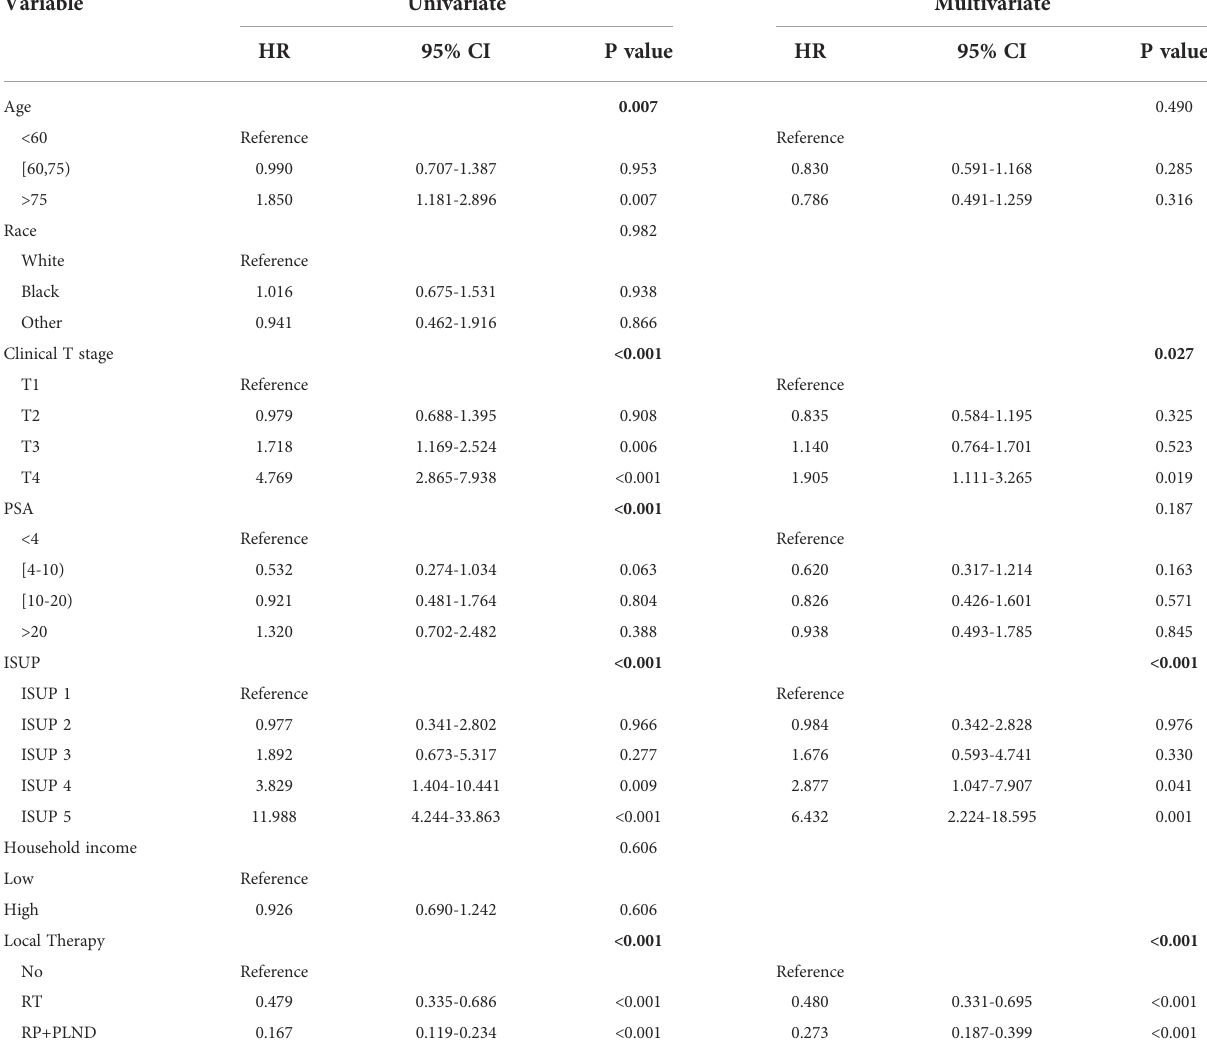
TABLE 2 Uni- and multivariate Cox regression models for predicting CSS in cN1M0 prostate cancer